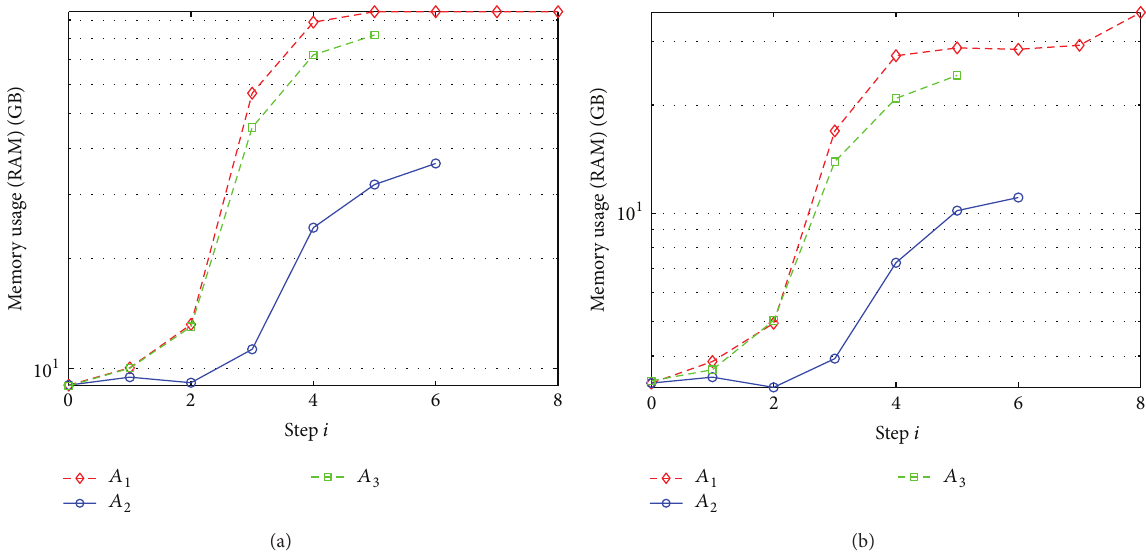
Figure 5: Evolution of the RAM for the computation of the electric field E (a) and of the temperature 𝑇 (b) with strategies 𝐴 1 , 𝐴 2 , and 𝐴 3